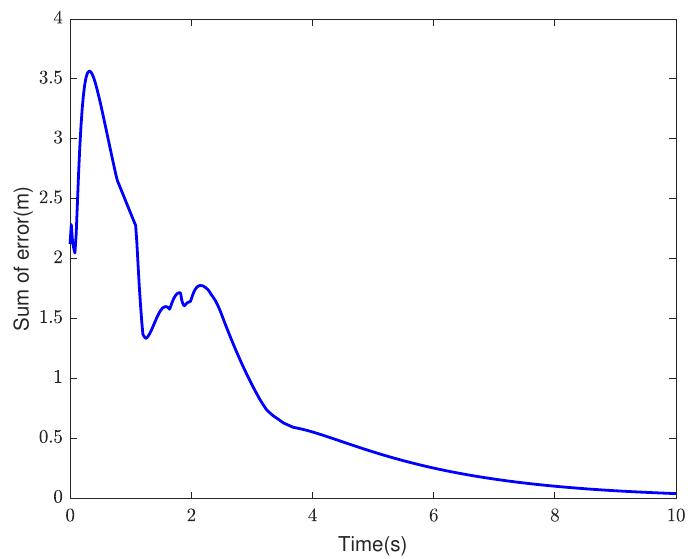
Figure 9. The sum of distance errors of 8